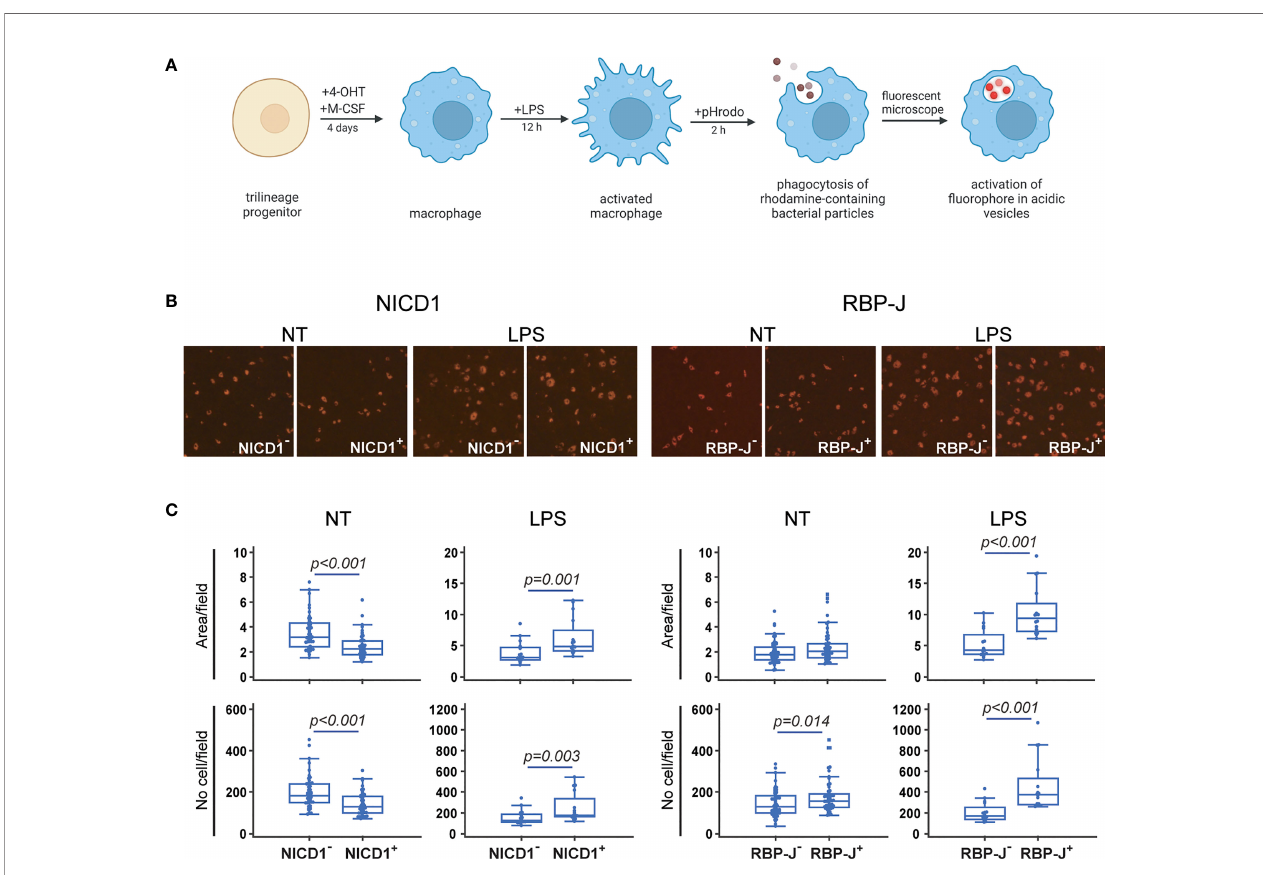
FIGURE 6 | Functional characterization of macrophages differentiated from the common trilineage progenitor (TLP) isolated from bone marrow cells of CX3CR1CreERT2/NICD1 (NICD1) and CX3CR1CreERT2/RBP-J (RBP-J) mice. Bone marrow cells were fl ushed from hind limb long bones and the common TLPs (A) Experimental design of macrophage differentiation and functional testing. Macrophage differentiation was induced by the addition of macrophage colony- stimulating factor (M-CSF). Cre-mediated recombination in Cre + (NICD1 + or RBP-J + ) littermates was induced by the addition of 4-hydroxytamoxifen (4-OHT). Cre − (NICD1 − or RBP-J − ) littermates treated with 4-OHT were used as controls. Lipopolysaccharides from E.coli (LPS) were added 12h before harvesting to induce the in fl ammatory response. Phagocytosis of rhodamine-containing bacterial particles was used as a functional assay. Created with BioRender.com (B) Representative images of culture wells with pHrodo + macrophages differentiated from TLP under LPS stimulation. Activation of rhodamine in acidic vesicles after phagocytosis was detected as pHrodo + macrophages (magni fi cation 100×). (C) Quanti fi cation of pHrodo + macrophages differentiated from TLP under LPS stimulation. Number and area of pHrodo + macrophages were expressed per fi eld of view. Pooled data from two independent experiments are shown (n=12-20). Individual values are presented; horizontal lines represent the median, boxes represent the interquartile range (IQR), whiskers represent 1.5 times the IQR. Statistically signi fi cant difference was determined at p<0.05, Mann – Whitney